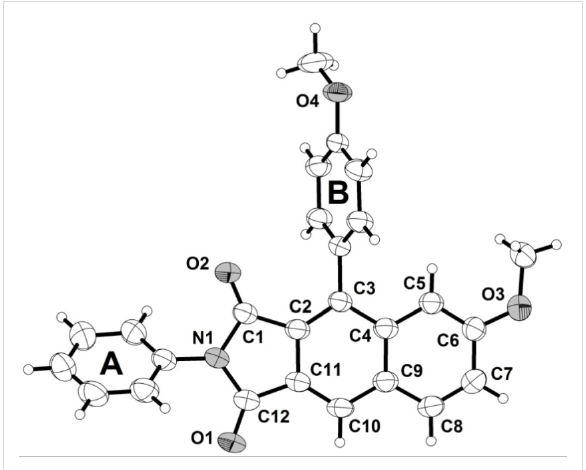
Figure 1: The ORTEP-style plot of crystal structure 4b (ellipsoids are draw at the 40% probability level).